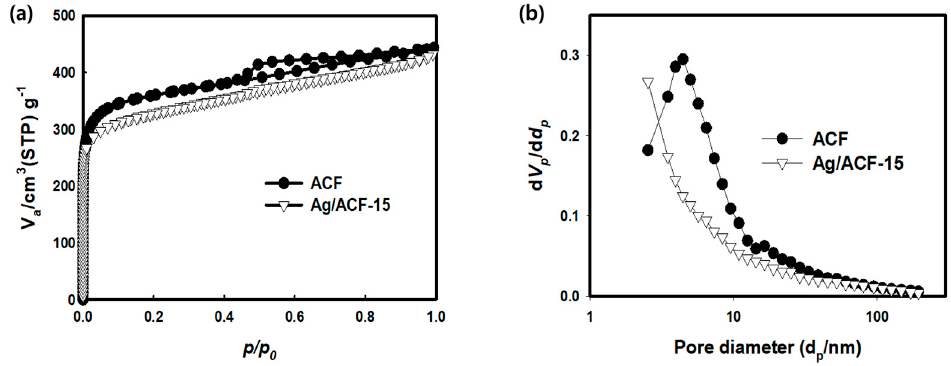
Figure 6. Adsorption–desorption isotherm curves ( a ) and pore size distribution ( b ) of ACF and Ag/ACF-15 composite.